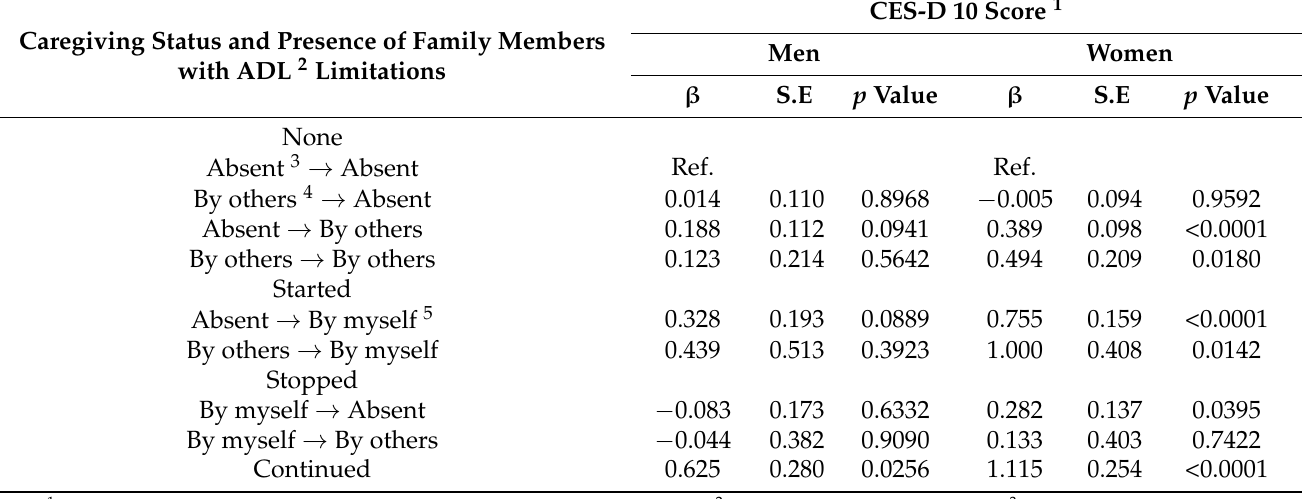
Table 3. Depressive symptoms based on caregiving status and presence of family members with ADL limitations.